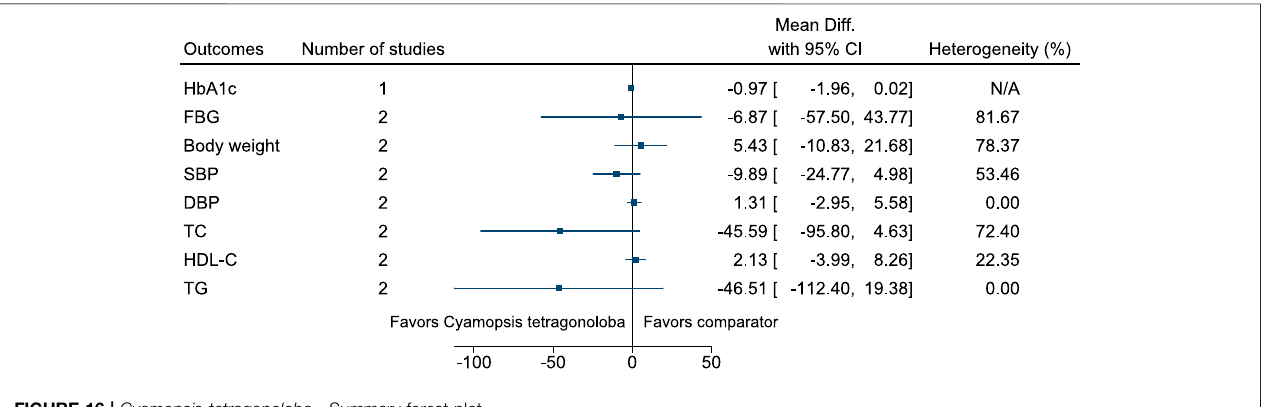
FIGURE 16 | Cyamopsis tetragonoloba — Summary forest plot.